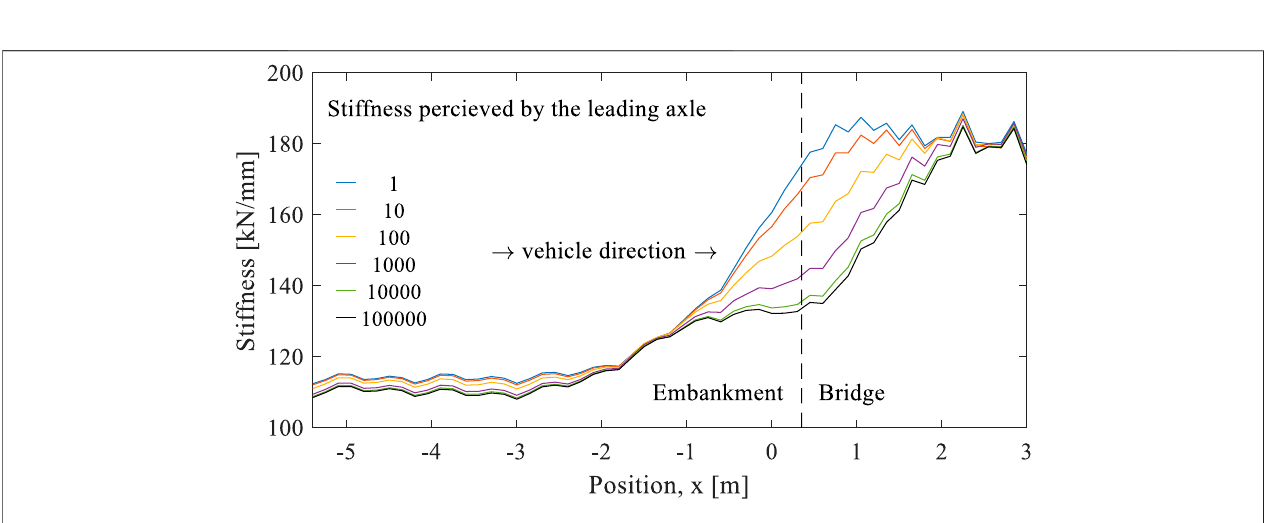
FIGURE 12 | Evolution of the track vertical stiffness perceived by the vehicle with N.